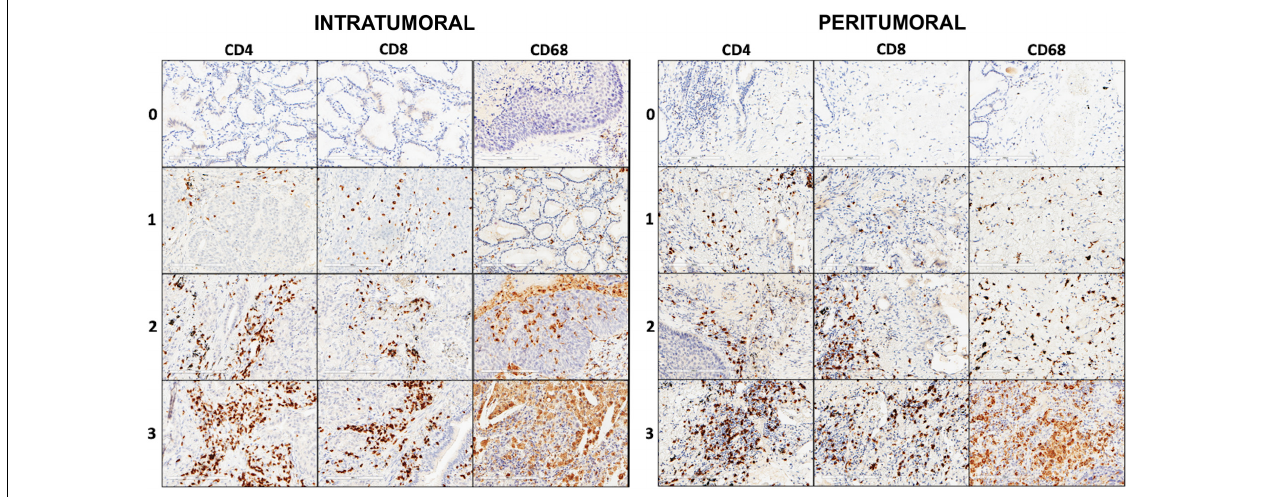
FIGURE 1 | Explicative pictures of the scores (0, 1, 2, 3) for each immunohistochemistry (IHC) marker (CD4, CD8, and CD68), respectively, in IT and PT areas (IHC, original magnification × 200).